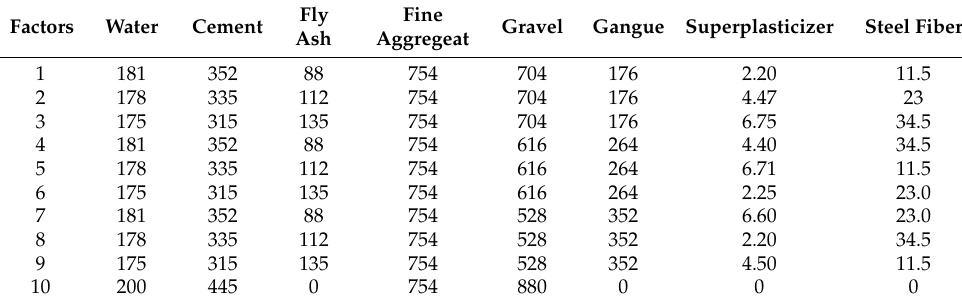
Table 5. Experimental scheme (unit: kg /m 3 ).